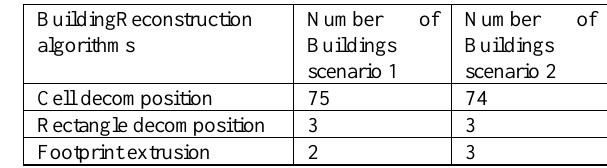
Table 2: Number of buildings reconstructed from